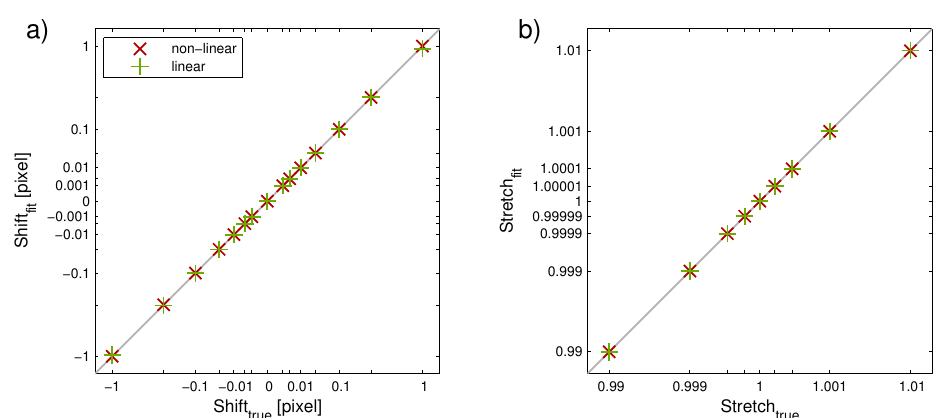
Fig. 4. Comparison of the fitted and the true shift (left panel, for stretch ≡ 1) and stretch (right panel, for shift ≡ 0) for the non-linear (red) and the linear fit including A Shift and A Stretch (green). The applied shifts and stretches are listed in Table 1. The grey line shows 1:1 correspondence. Note that the scales are non-linear to show the full range of variations over some orders of